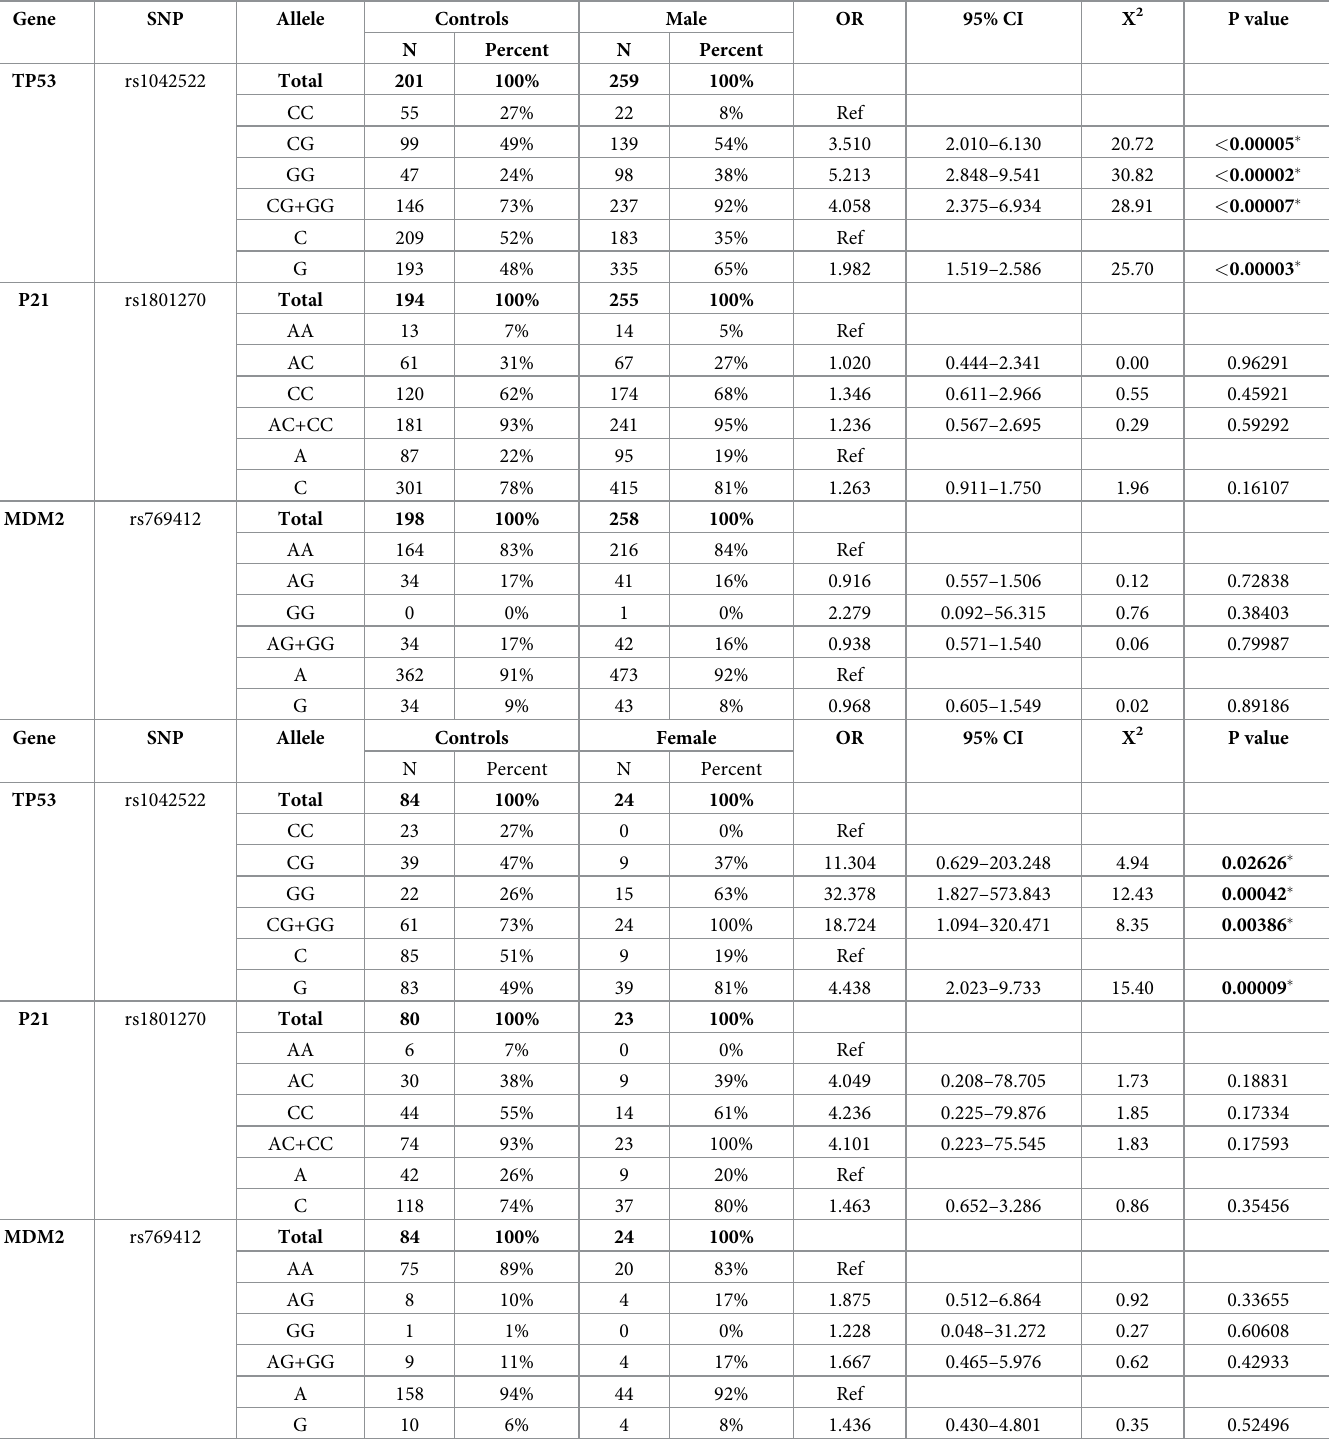
Table 4. Genotype and allele frequencies of SNPs in P53, P21, and MDM2 genes in male and female smokers and controls. Gene